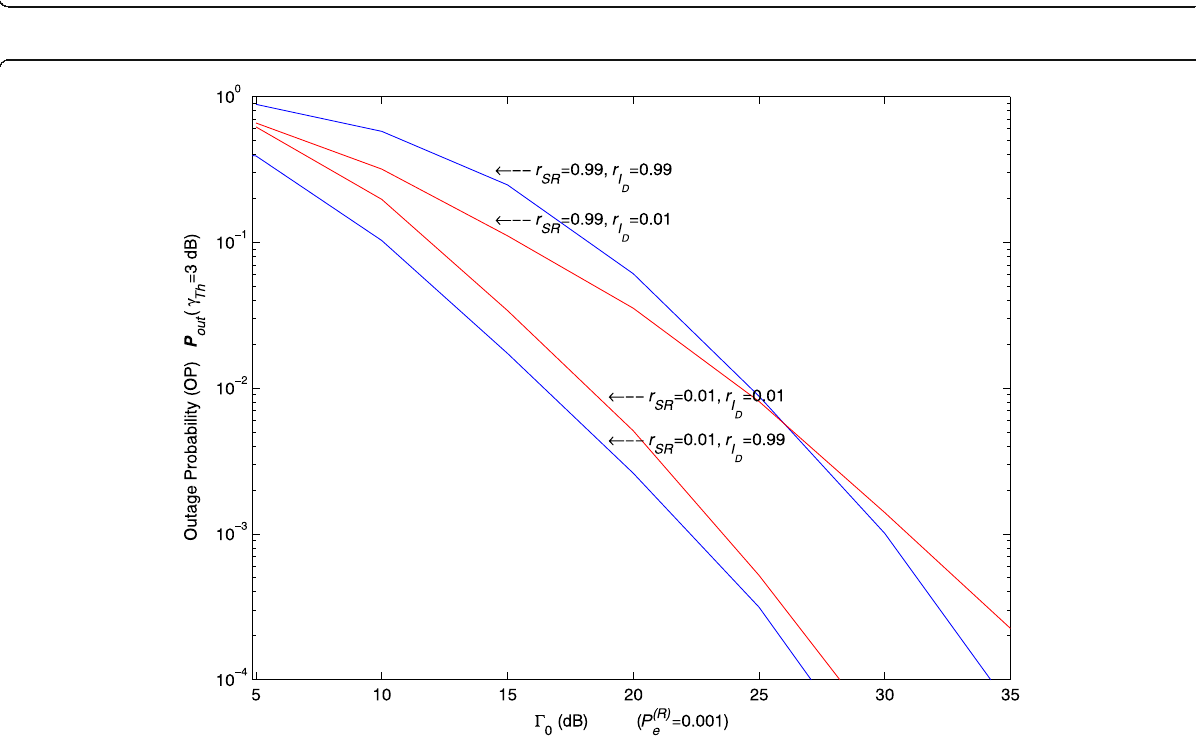
Fig. 4 The outage probability, P out ( γ Th ), for various r SR values in the presence of fast-fading multiple correlated CCIs ( r I ð R Þ Γ total ¼ 10 dB, γ ¼ 0 : Th =3 dB, and P e 1